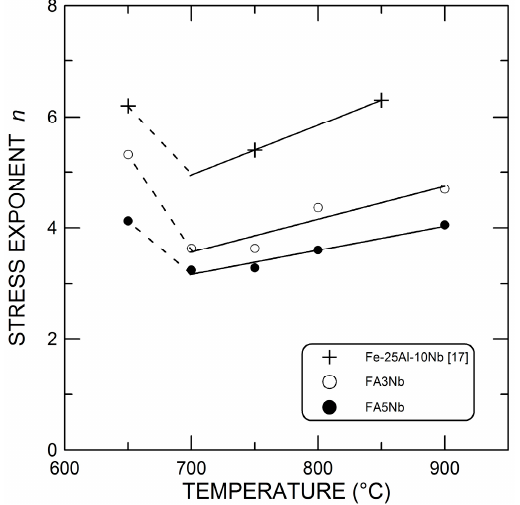
Figure 5. Dependence of stress exponent n on temperature.